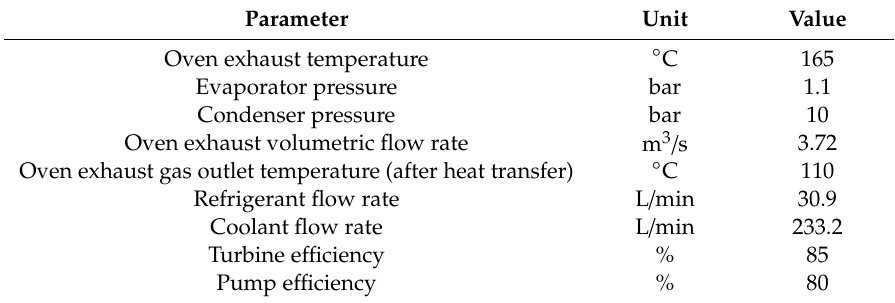
Table 3. List of operating parameters to the Regenerative Organic Rankine Cycle (RORC) Aspen Plus